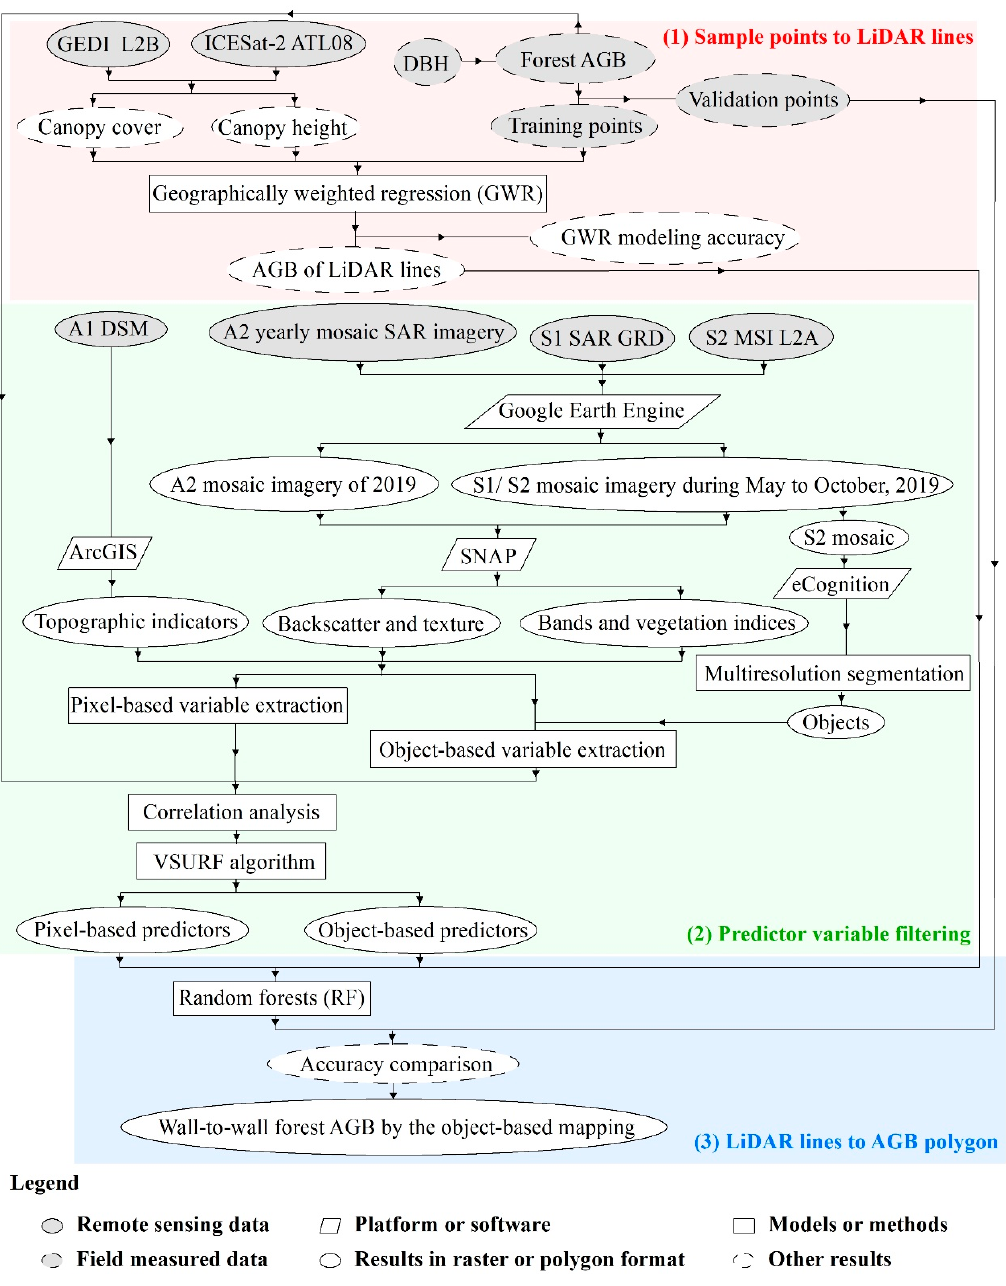
Figure 2. Overall workflow of object-based mapping of forest AGB by integrating LiDAR data with MSI and SAR images. MSI and SAR